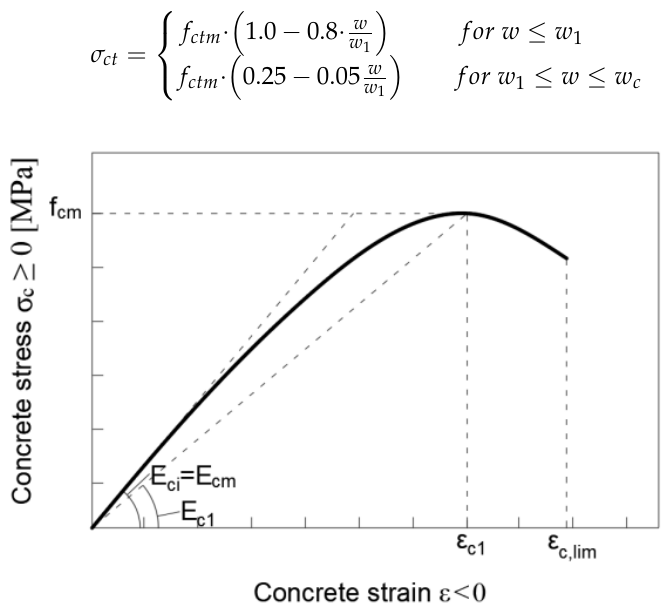
Figure 5. Schematic representation of the stress – strain relation for uniaxial compression.